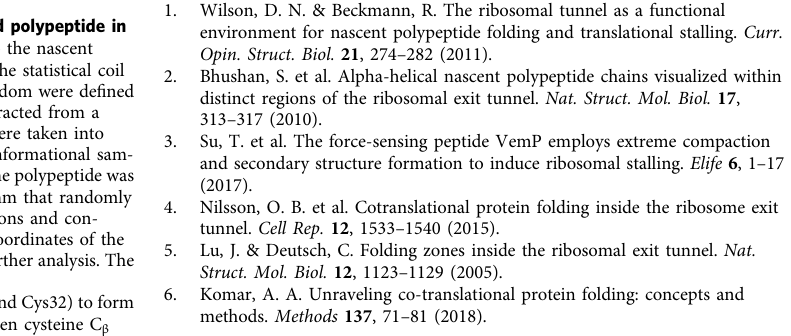
Figure preparation . All fi gures were prepared using Pymol 4.6 (Schrödinger, LLC.), USCF Chimera 1.14 (ref. 64 ) or USCF ChimeraX 1.0 (ref. 71 ). Reporting summary . Further information on research design is available in the Nature Research Reporting Summary linked to this